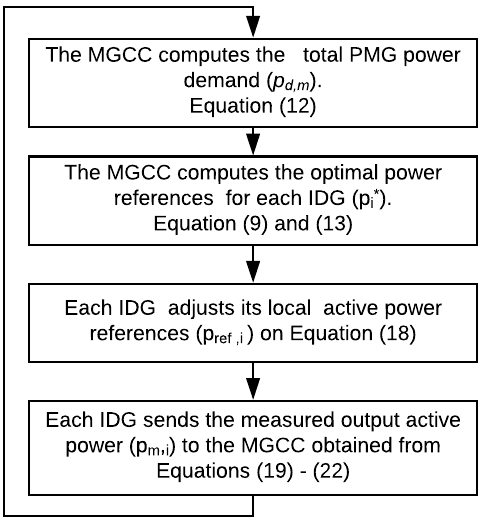
Figure 3. Flow diagram of the proposed